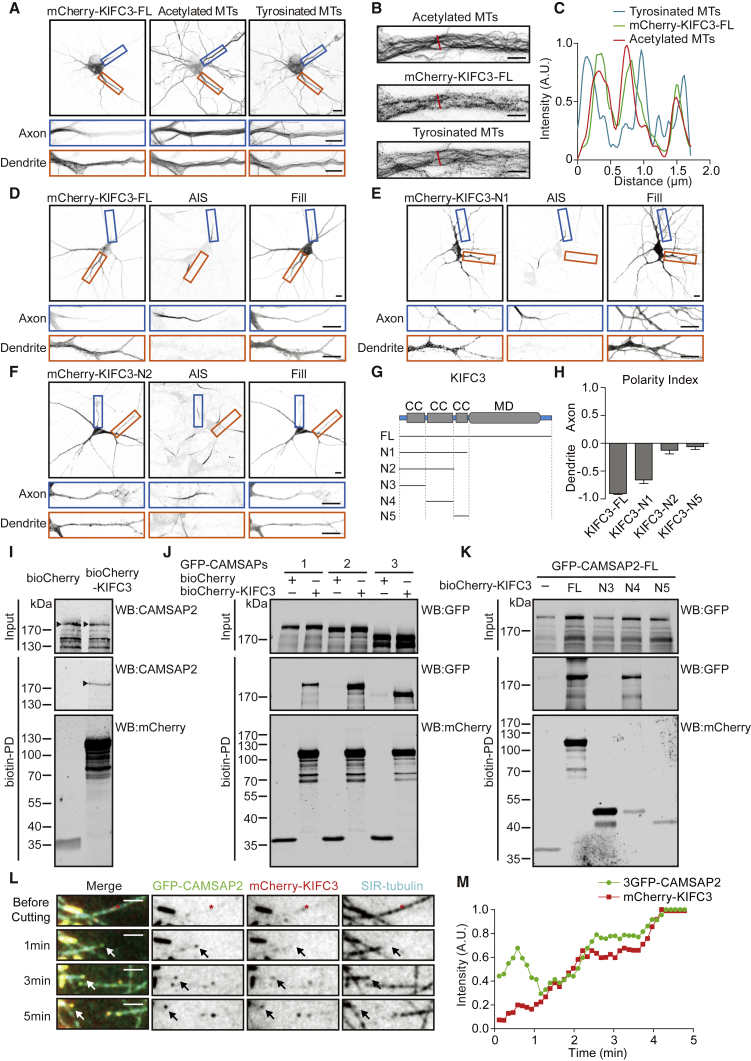
KIFC3 Localizes to Dendrites and Interacts with CAMSAP2(A and B) Representative images of DIV11 hippocampal neurons transfected with mCherry-KIFC3-FL and co-stained with acetylated tubulin and tyrosinated tubulin antibody.(A) Selected axonal (marked with a blue box) and dendritic (marked with an orange box) regions are enlarged below. Scale bars, 10 μm and 5 μm in enlargements.(B) Further enlargement of a dendrite region is shown. Scale bars, 2 μm.(C) Intensity profile of the indicated region in (B).(D–F) Representative images of DIV10 hippocampal neurons transfected with GFP fill and mCherry-KIFC3-FL (D), mCherry-KIFC3-N1 (E), or mCherry-KIFC3-N2 (F) and stained for TRIM46 to visualize the axon initial segment (AIS). Selected axonal (marked with a blue box) and dendritic (marked with an orange box) regions are enlarged below. Scale bars, 10 μm.(G) Schematic representation of the KIFC3 secondary structure and truncation constructs used. CC, coiled-coiled domain; MD, motor domain.(H) Polarity index analysis from KIFC3-FL and truncations corresponding to (D)–(F). Positive values indicate axon enrichment, and negative values indicate dendrite enrichment. Error bars, SEM. N = 2. KIFC3-FL: n = 12, KIFC3-N1: n = 10, KIFC3-N2: n = 9, and KIFC3-N5: n = 6.(I) Biotin pull-downs from extracts of HEK293T cells transfected with BirA recognition site conjugated mCherry-KIFC3-FL and probed for mCherry and CAMSAP2. For all pull‐down experiments, the input is 25% of the biotin pull-down. CAMSAP2 was found from KIFC3 pull-downs with brain extracts (Table S1). The interaction is also proved by co-localization experiment in neurons and COS7 cells (Figure S2; Video S1).(J) Biotin pull-downs from extracts of HEK293T cells transfected with BirA recognition site conjugated mCherry-KIFC3-FL together with GFP-tagged CAMSAP1, 2, or 3 and probed for mCherry and GFP.(K) Biotin pull-downs from extracts of HEK293T cells transfected with BirA recognition site conjugated KIFC3 truncation constructs together with GFP-tagged CAMSAP2 and probed for mCherry and GFP.(L) Representative images of COS7, transfected with 3GFP-CAMSAP2 and mCherry-KIFC3 (Video S2). Silicon rhodamine (SIR)-tubulin was applied to visualize microtubules. Microtubule photoablation was indicated by red stars. Minus end was indicated by white and black arrows. 3GFP-CAMSAP2 was shown in green, mCherry-KIFC3 in red, and SIR-tubulin in cyan. Scale bars, 2 μm.(M) The quantification of CAMSAP2 and KIFC3 puncta intensity corresponding to (L).